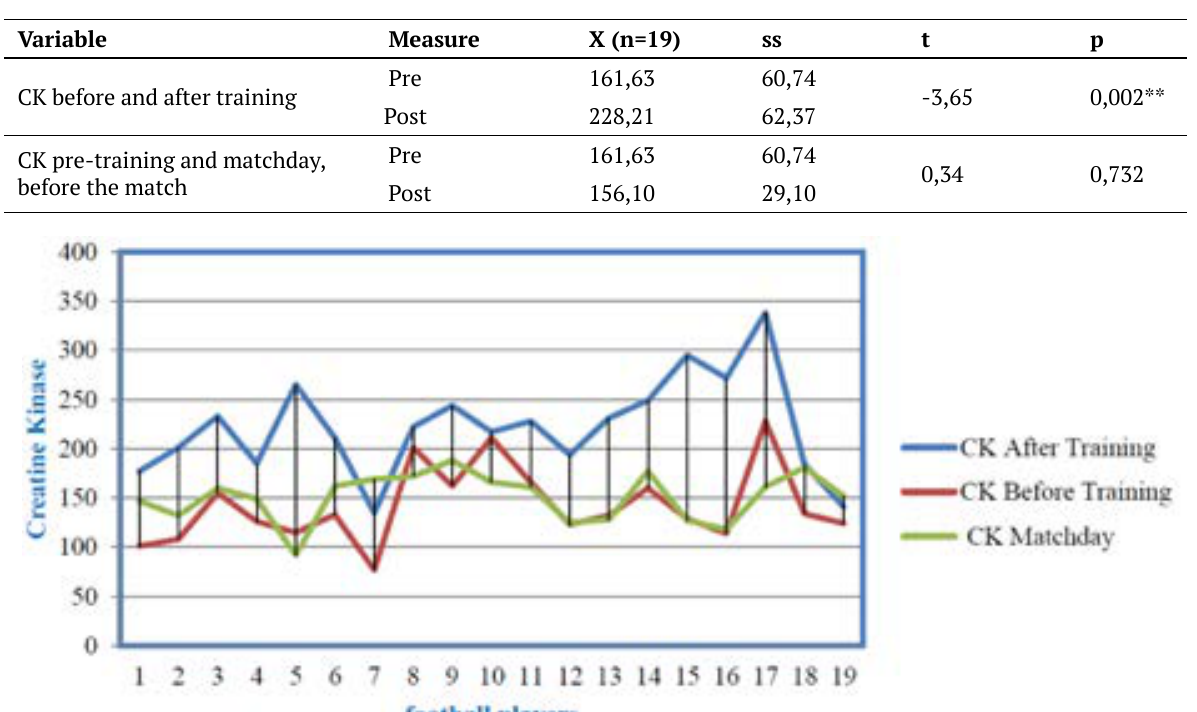
Table 6. Analysis results for “pre-test and post-test” values for variables of blood values of footballers participating in the study.